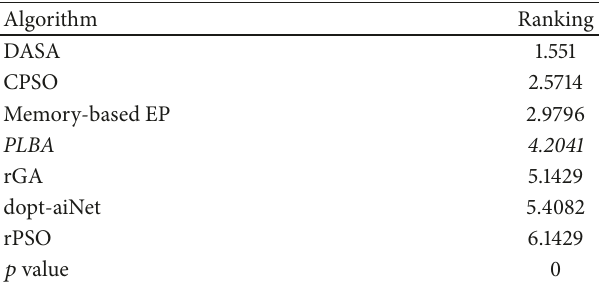
Table 17: Adjusted 𝑝 values associated with PLBA and other algorithms (Friedman) on dynamic benchmark problems 𝐹 1 – 𝐹 6 in terms of both solution quality and convergence